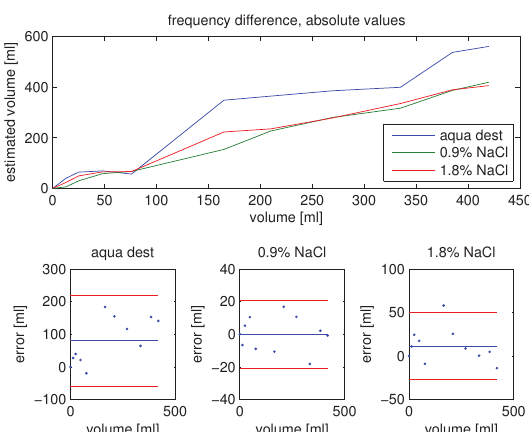
Fig.14: In-vitro results for frequency-differential variant using ab- solute values: the results from simulation could not be reproduced, probably by an impact of varying electrode contact impedances on the measurement